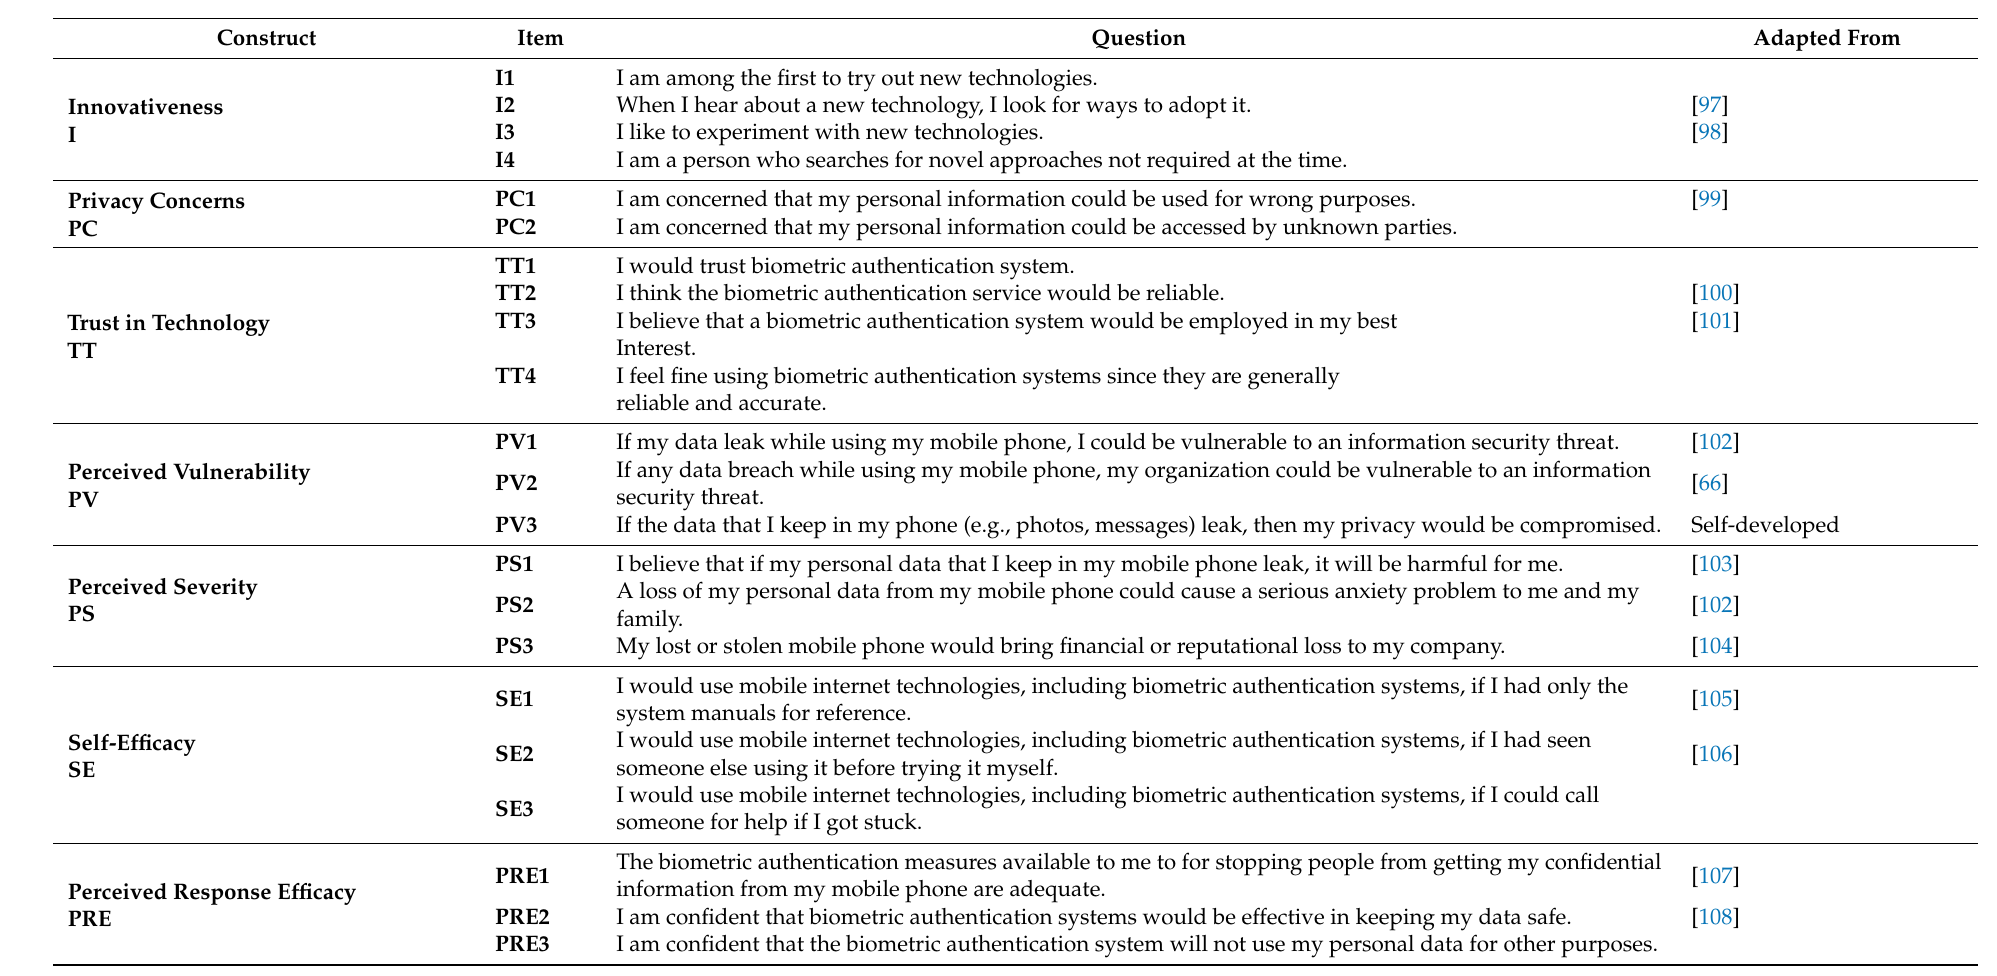
Table A1. Bioprivacy Survey